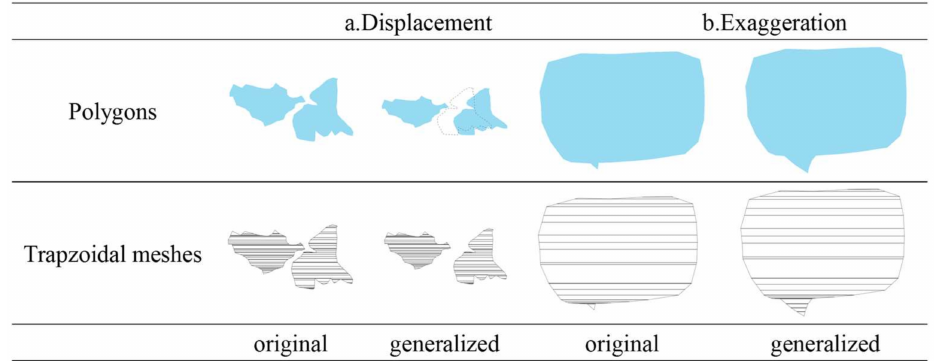
Figure 10. Additional possible sophisticated operators to support polygon displacement and